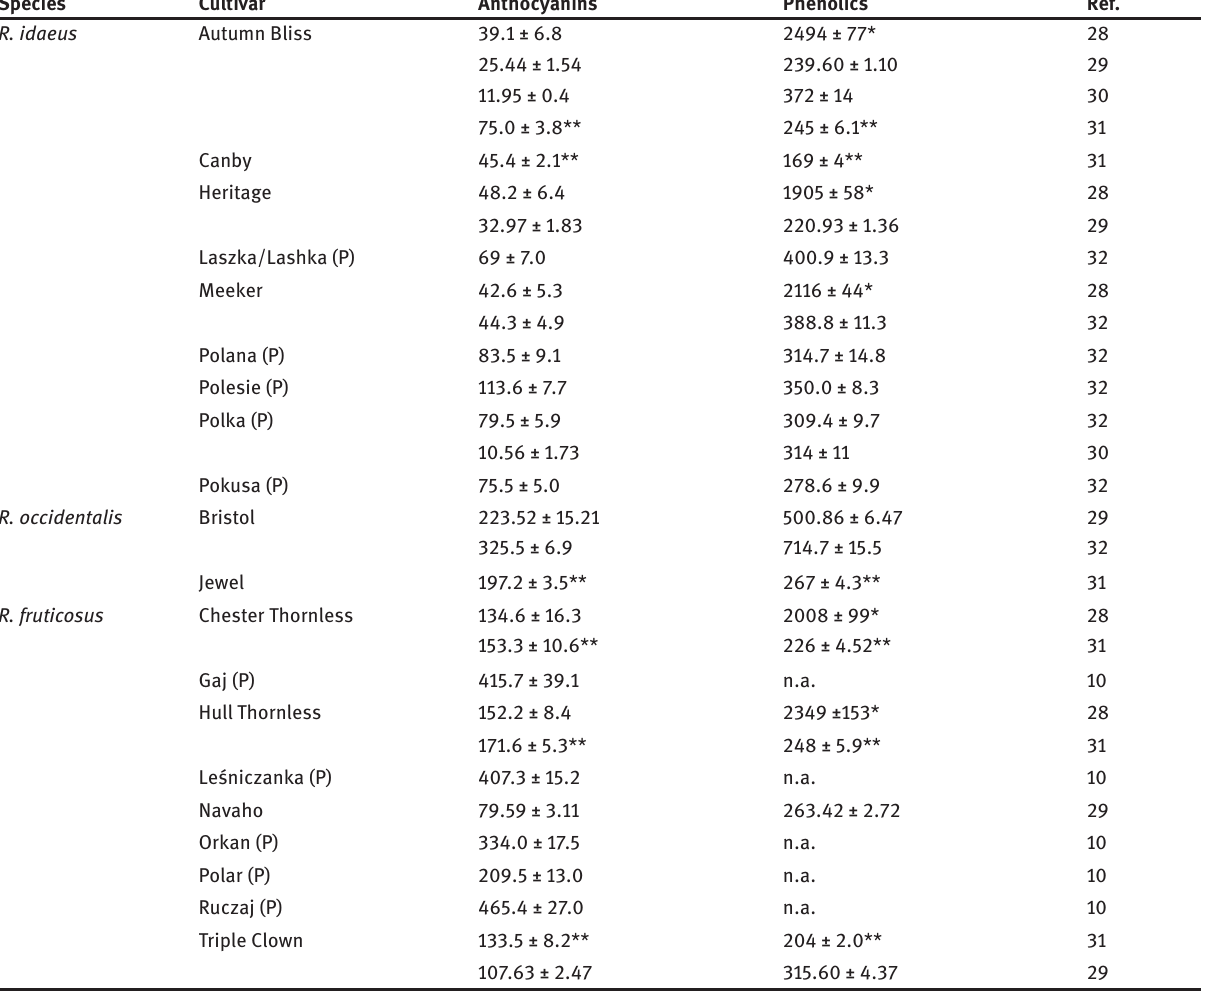
Table 1: Comparison of total phenolic (mg gallic acid eq. 100 g –1 fw) and total anthocyanin (mg cyanidin 3-glucoside eq. 100 g –1 fw) content in representative red raspberry ( R. idaeus ), black raspberry ( R. occidentalis ) and blackbberry ( R. fruticosus ) fruits of cultivars grown in central